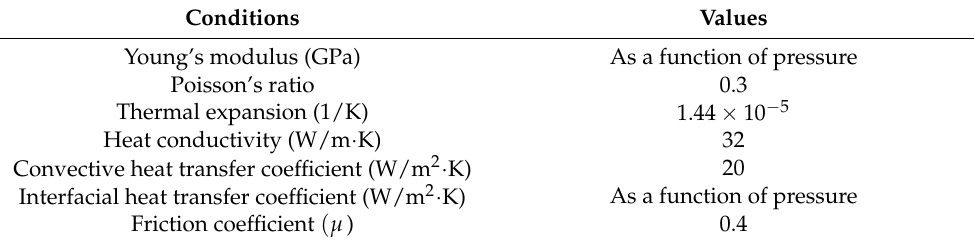
Table 1. Material constants of boron steel in the FE simulation [17,18].